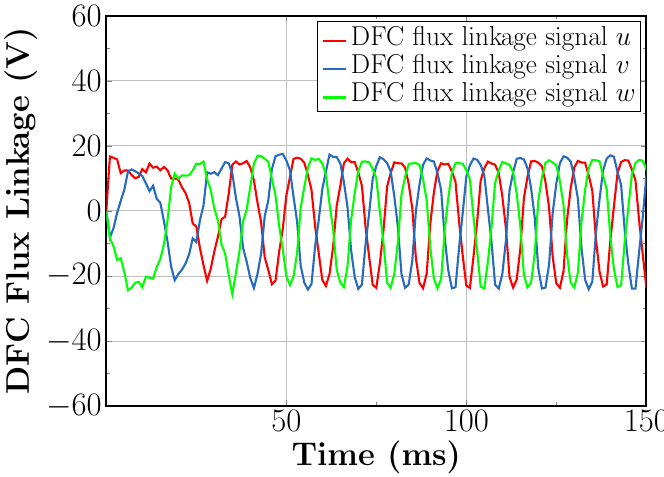
Figure 15. Sensorless speed control for 1200 RPM, DFC flux linkage